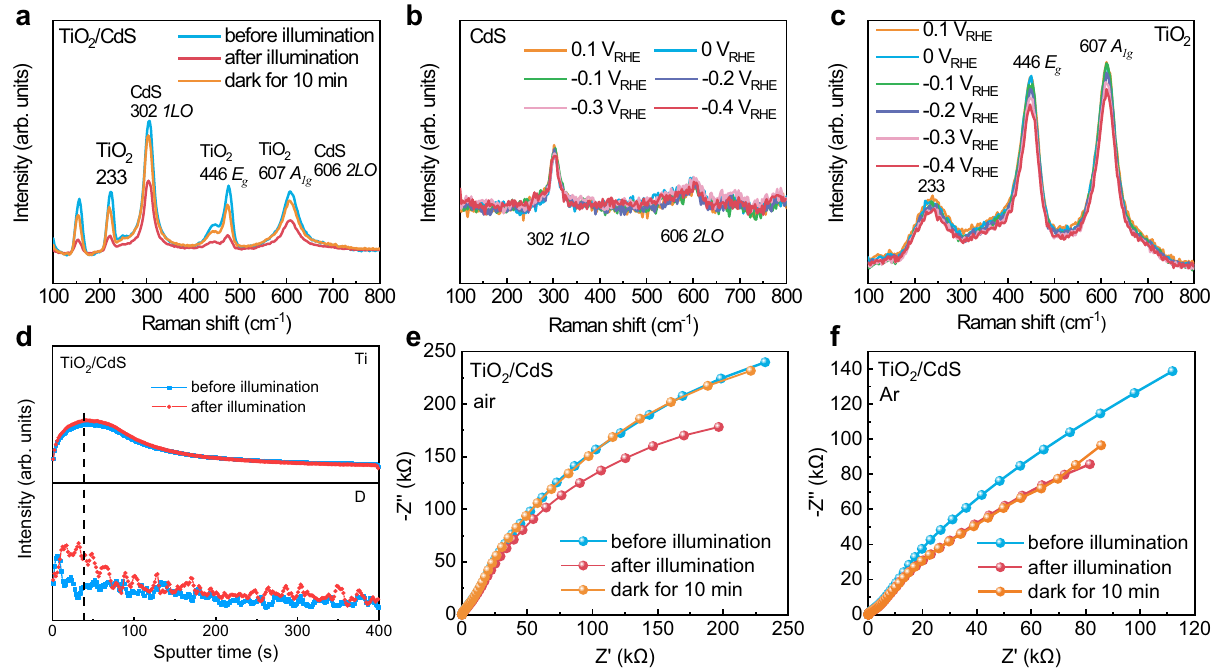
Fig. 3 Interface change and ion-depth pro fi les in TiO 2 /CdS under illumination. a Quasi in situ Raman spectra of TiO 2 /CdS before and after illumination under full-arc Xe lamp, in situ Raman spectra of CdS ( b ) and TiO 2 ( c ) in 1 M Na 2 S aqueous solution at different potentials in the dark, ( d ) secondary ion intensities of Ti and D ions in a TiO 2 /CdS junction in the electrolyte (1 M Na 2 S in D 2 O solution) before and after illumination for 10 min, electrochemical- impedance spectroscopy @0.4 V RHE of TiO 2 /CdS in 1 M Na 2 S aqueous solution with air ( e ) and with Ar ( f ) before and after illumination under full-arc Xe